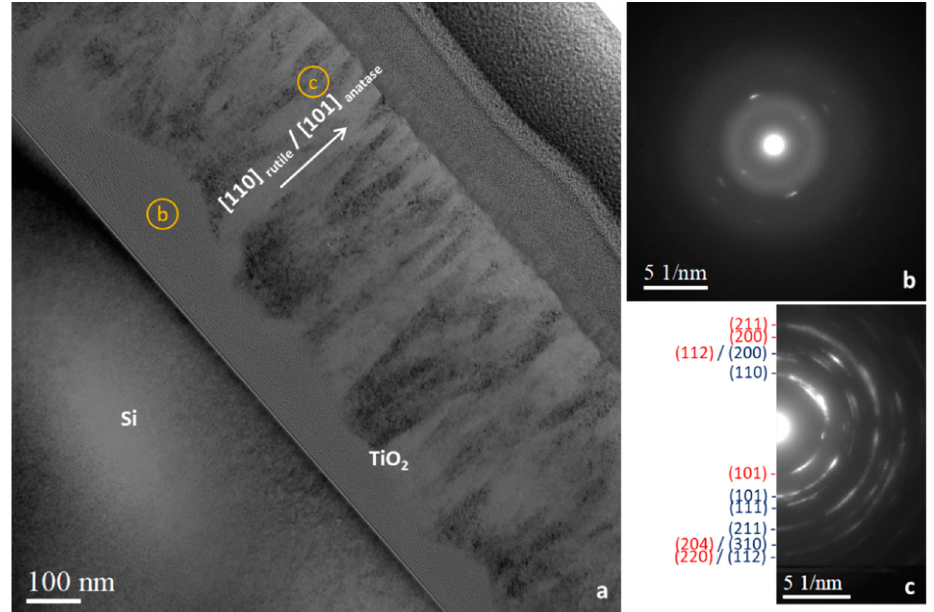
Figure 6. ( a ) TEM image of as-deposited TiO 2 thin film (M7T) with corresponding selected area electron diffraction patterns near the Si/TiO 2 interface ( b ) and at the TiO 2 film surface ( c ). The diffraction rings have been labeled with the corresponding lattice planes (hkl) (anatase in red, rutile in dark blue).